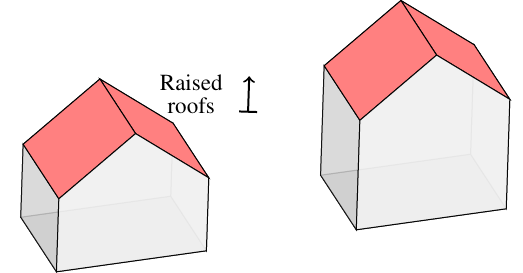
Figure 3. An example of a building before (left) and after (right) its roof surfaces have been raised without changing their form.